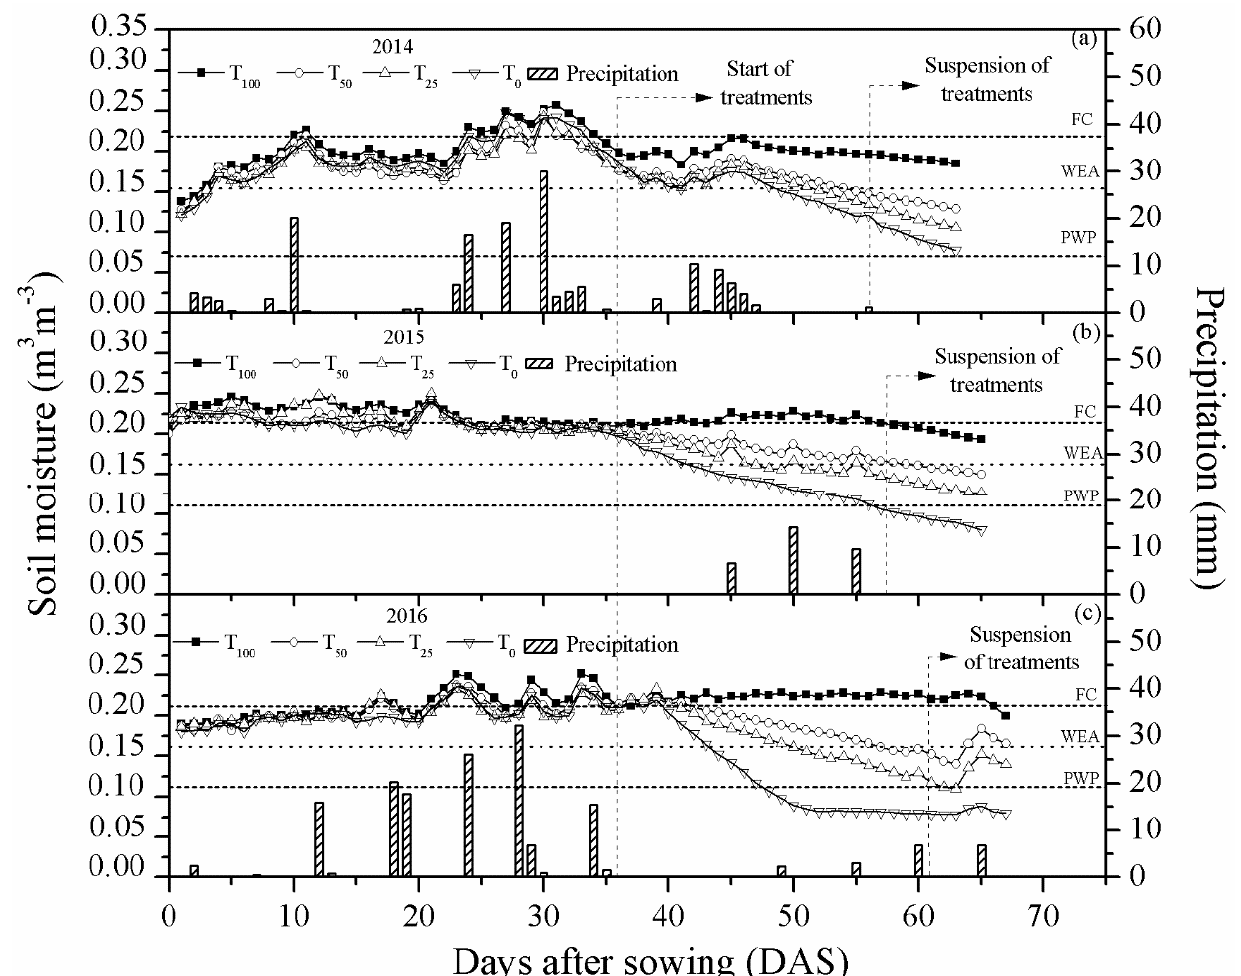
Figure 2. Variation of soil moisture and total daily precipitation in the experimental area during the years 2014 ( a ), 2015 ( b ), and 2016 ( c ) in Castanhal-PA. FC: Field capacity; WEA: Water easily available; PWP: Permanent wilting point; Precipitation; ■ T 100 : Replacement of 100% of evapotranspiration of culture (ETc); ○ T 50 : Replacement of 50% ETc; Δ T 25 : Replacement of 25% ETc; ▽ T 0: Does not have irrigation during the reproductive phase.